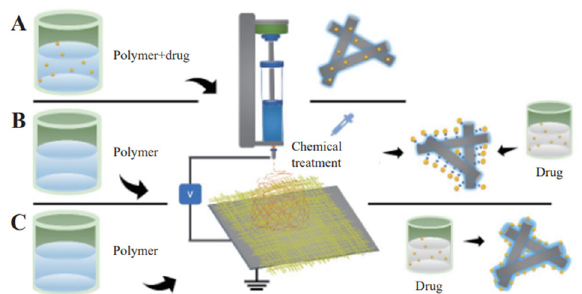
Fig. 2 Schematic diagram of different drug loading methods, such as encapsulation ( A ), chemical immobilization ( B ), and physical adsorption ( C )